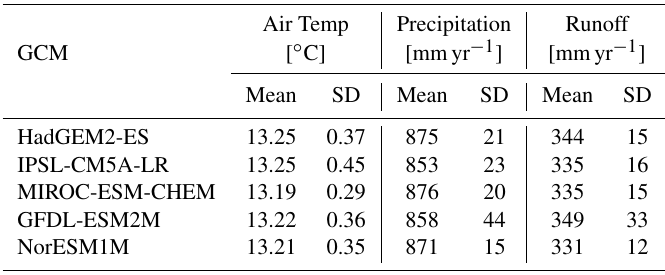
Table 1. Contemporary (1950–2006) global average air temperature, precipitation and runoff (estimated using WBM plus ) based on five bias corrected GCM hind-casts.